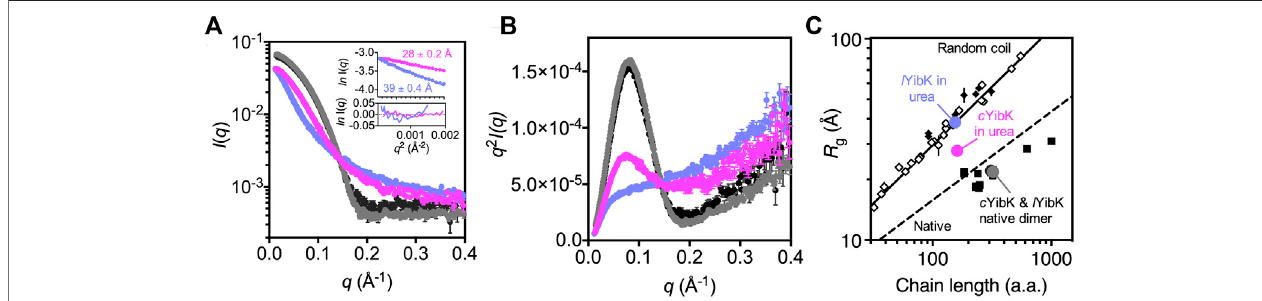
FIGURE 5 | Cyclization signi fi cantly reduces the global dimension of the denatured state of c YibK. (A) SAXS pro fi les of l YibK in 0 M urea (gray), c YibK in 0 M urea (black), l YibK in 7 M urea (orchid blue), and c YibK in 7 M urea (magenta). Inset: Guinier plots of l YibK and c YibK in 7 M urea with the corresponding R g values indicated and fi tting residues shown below. (B) Kratky plots of l YibK and c YibK in their native and 7 M urea-denatured states, as shown in (a). Urea-denatured c YibK exhibits a distinctbell-shape pro fi le,indicative ofcompactresidualstructuresthatareabsentinurea-denatured l YibK. (C) R g valuesof l YibKand c YibKintheirnativeand7 M urea-denatured states as a function of chain length. The solid and dashed lines indicate the experimentally derived scaling relationship for random-coil and native proteins, respectively. Solid squares and diamonds correspond to reported R g values of knotted proteins of different topologies and chain lengths. Open diamonds correspond to reported random-coil R g values of chemically denatured unknotted proteins (Shih et al., 2015).